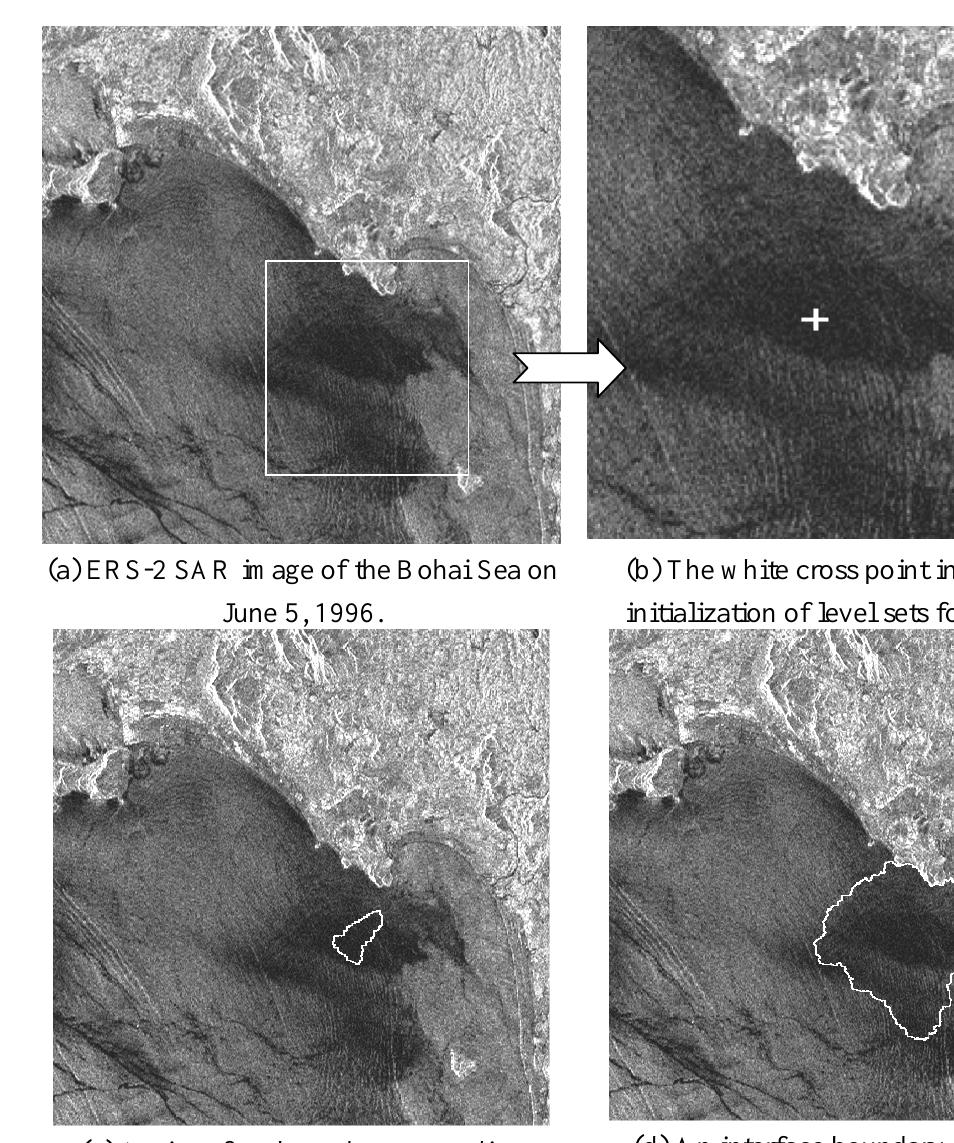
Figure 5. The proposed fast level set method with single seed for initialization of level sets.